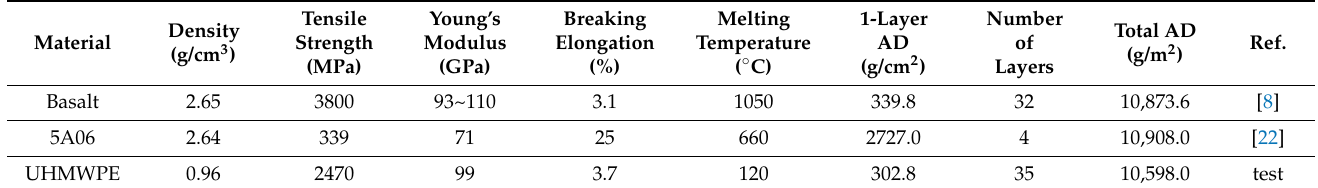
Table 1. Experimental material properties.